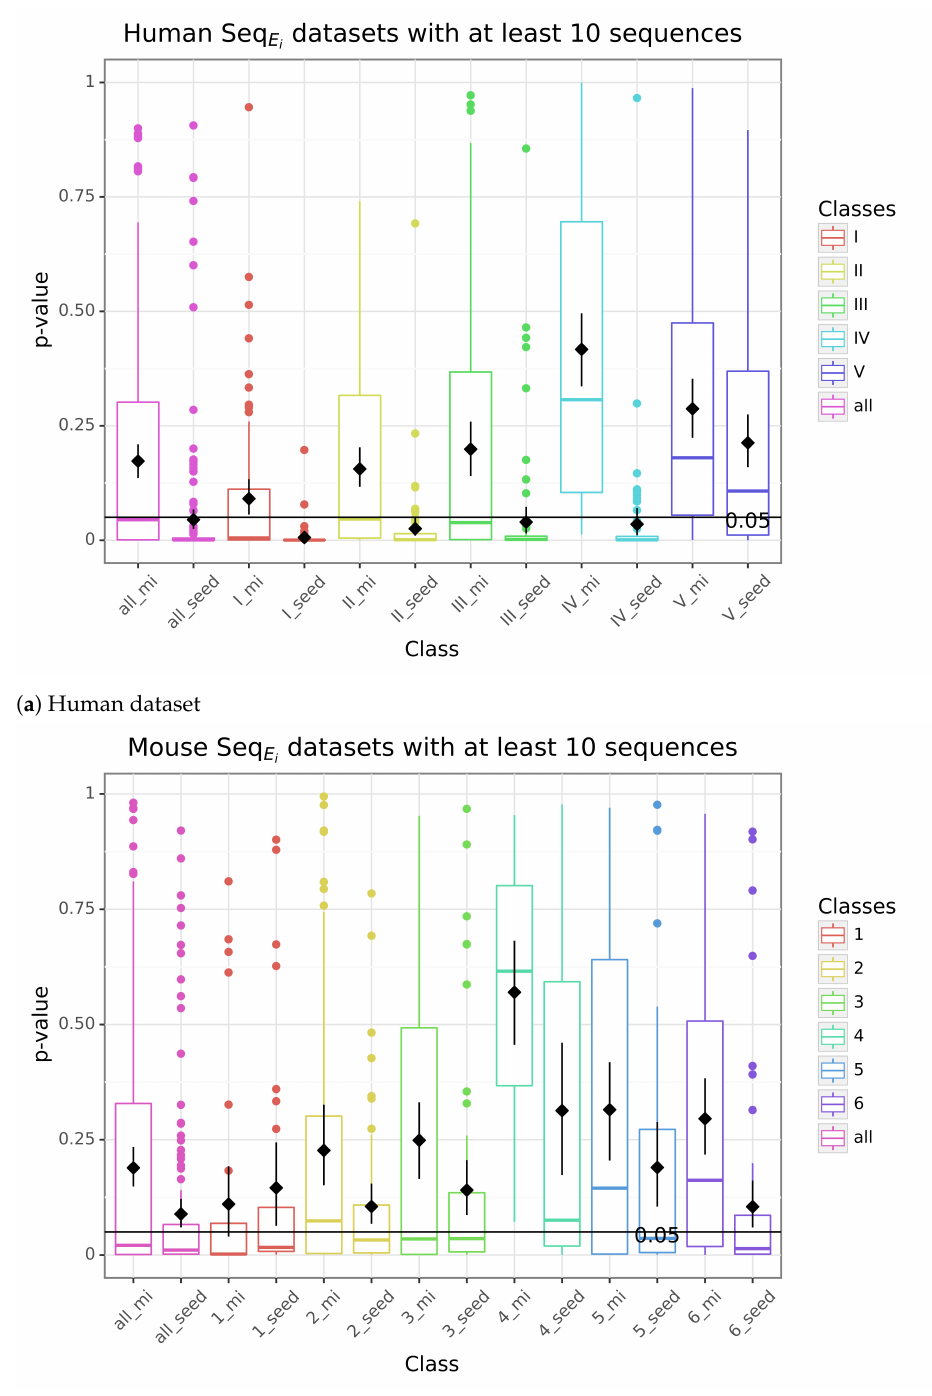
Figure 5. P-values from the comparison of the motifs with the exact interaction sites on the mRNAs as identified on the human and mouse CLASH datasets. The boxplot indicates the distribution of the p-values for each class when comparing the best motif predicted by M EME with either the seed (seed) or the miRNA (mi) on datasets with 10 or more